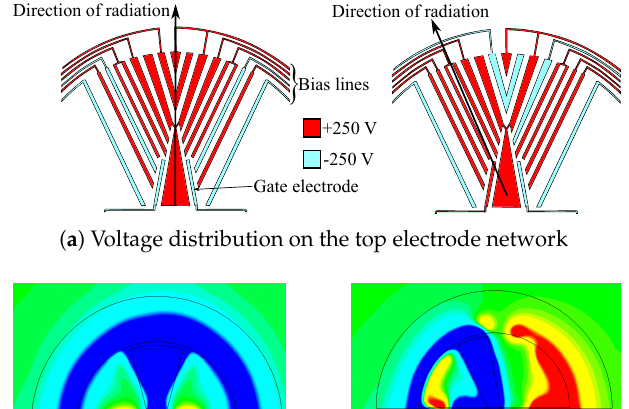
Figure 46. Representation of the fully dielectric lateral wave beam steering antenna [47]. Lengths are in mm. Reprinted with kind permission of IEEE.